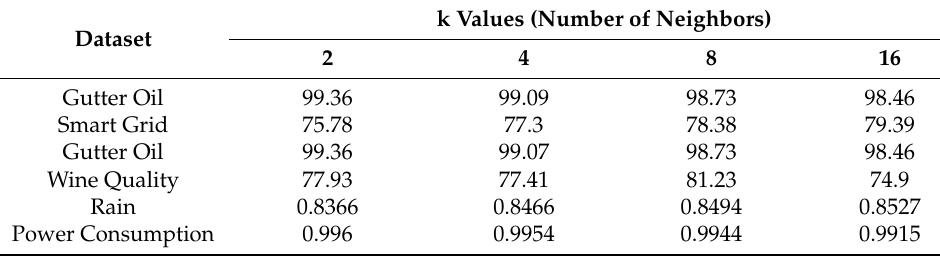
Table A5. The score for different k-NN architectures.